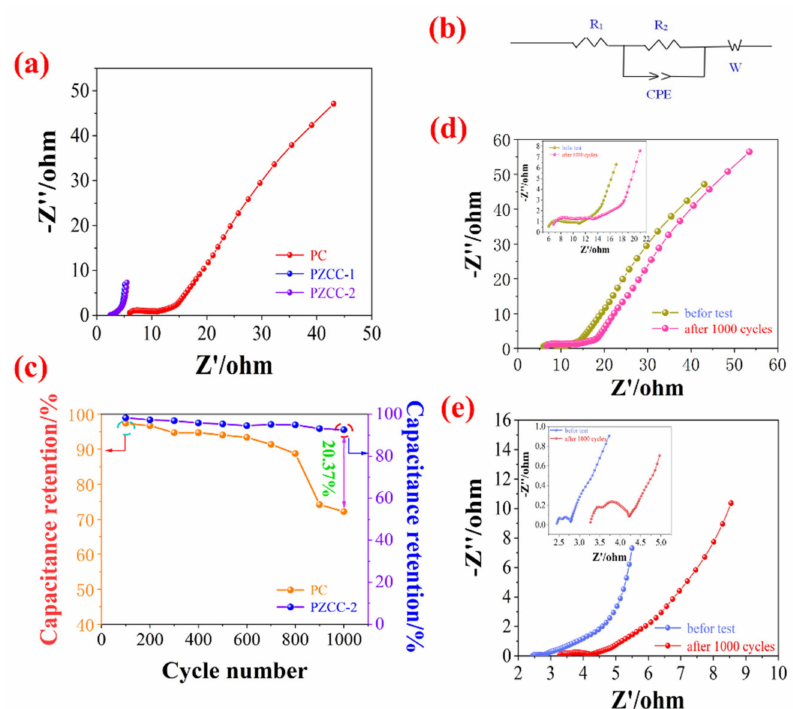
Figure 9. ( a ) Comparative Nyquist plots of PC, PZCC-1, and PZCC-2 electrode materials, ( b ) EIS circuit of electrode materials, ( c ) capacitance retention of PC and PZCC-2 electrode materials, and ( d , e ) Nyquist plots of PC and PZCC-2 electrode materials before and after 1000 cycles. To investigate the electrochemical performance of PZCC-2-SCs, the CV and GCD 0–0.8 V, and the corresponding results are shown in Figure 10. The specific capacitance is 234.50, 175.19, 104.25, 74.49, 56.30, and 35.03 mF · cm − 2 . Then, the volumetric